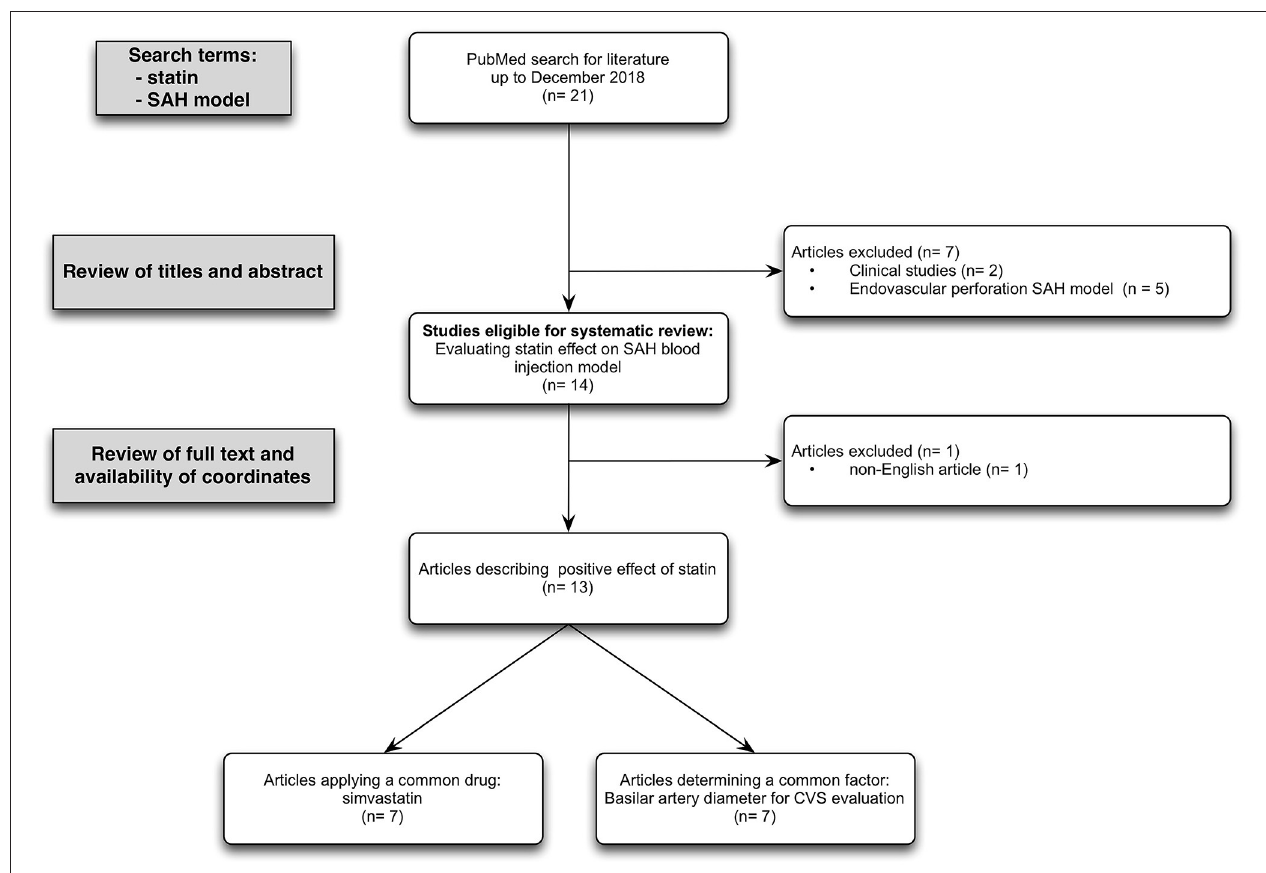
FIGURE 1 | PRISMA flow diagram: Flow chart summarizing the study selection process. Inclusion criteria required animal-based experimental studies focusing on statin effect in case of SAH induced by subarachnoidal blood injection model. Exclusion criteria required studies reporting on the application of an endovascular perforation SAH model and language other than English. Overall, 13 studies met the inclusion and exclusion